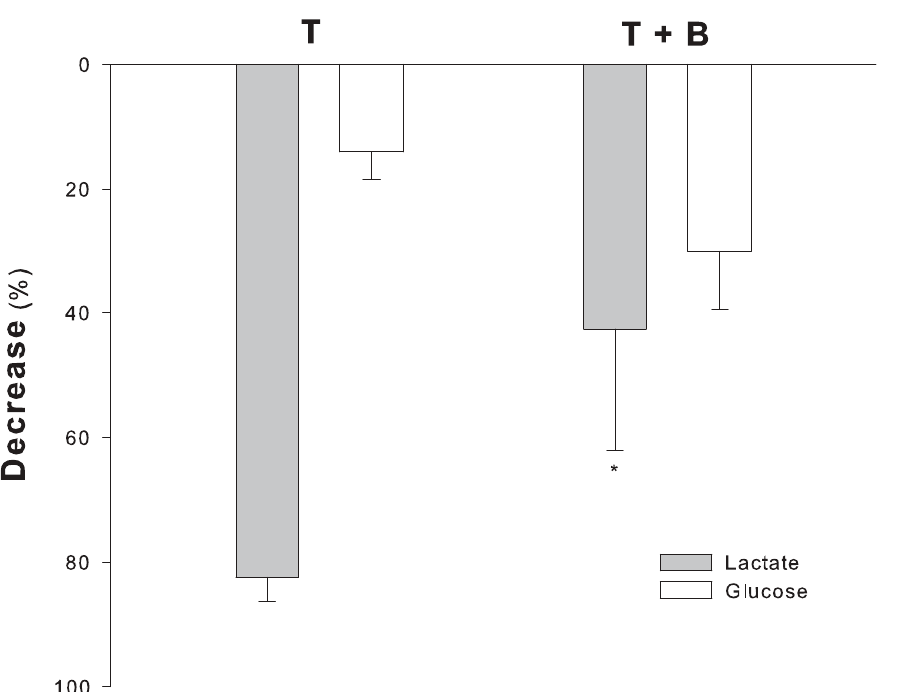
Figure 4. Blood lactate and blood glucose decrease in transient lactic acid infusion group. Decrease over time of blood lactate concentration and glycaemia in the animals with transient lactic acid infusion. Values are expressed as percentage decrease from time 75 to 135 (*P , 0.05 vs. transient group).